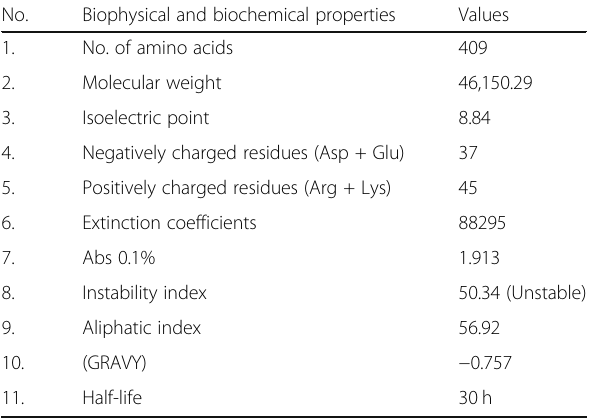
Table 2 Physicochemical properties of lysyl oxidase protein No. Biophysical and biochemical